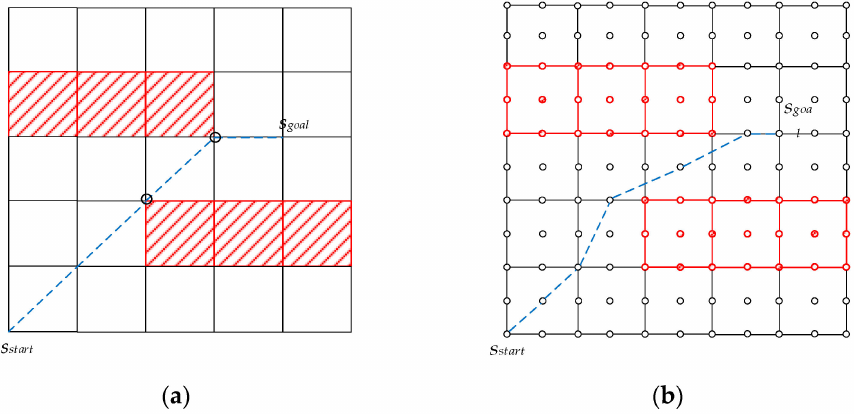
Figure 13. Theta* planning options for grids and grid points. ( a ) Theta* algorithm route planning under grid and ( b ) Theta* algorithm route planning under grid